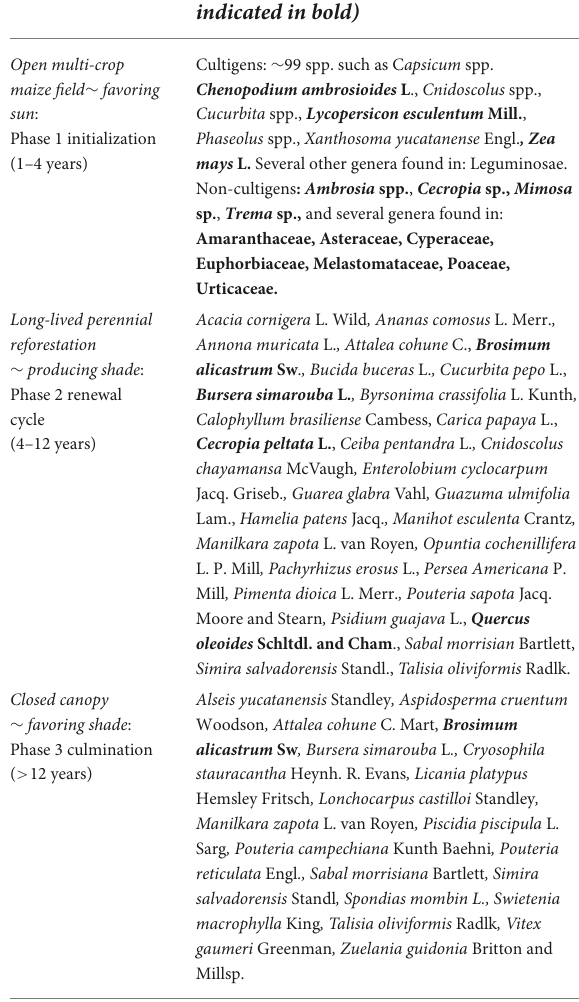
TABLE 2 Dominant plants of the milpa forest garden cycle from the greater Petén*. Milpa